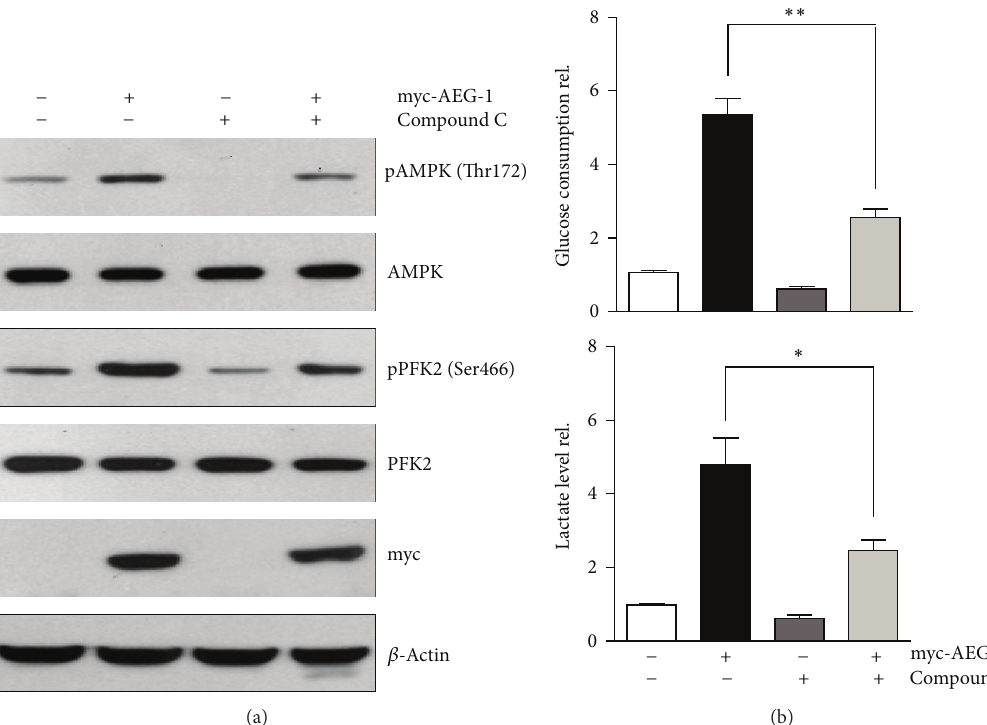
Figure 3: Inhibition of AMPK signaling reverses AEG-1-mediated increasing of glycolysis. (a) Western blots showing that inhibition of AMPK activity by Compound C (20 𝜇 M, 2 h) reduced AMPK phosphorylation and PFK2 phosphorylation in both AEG-1-overexpressed and nontransfected NCM460 cells. (b) Biochemical assays showing that inhibition of AMPK activity ameliorated AEG-1-induced glucose consumption and lactate production in NCM460 cells. Results were averages of four independent experiments. Data represent mean ± SEM. ∗ 𝑃 < 0.05 , ∗∗ 𝑃 < 0.01